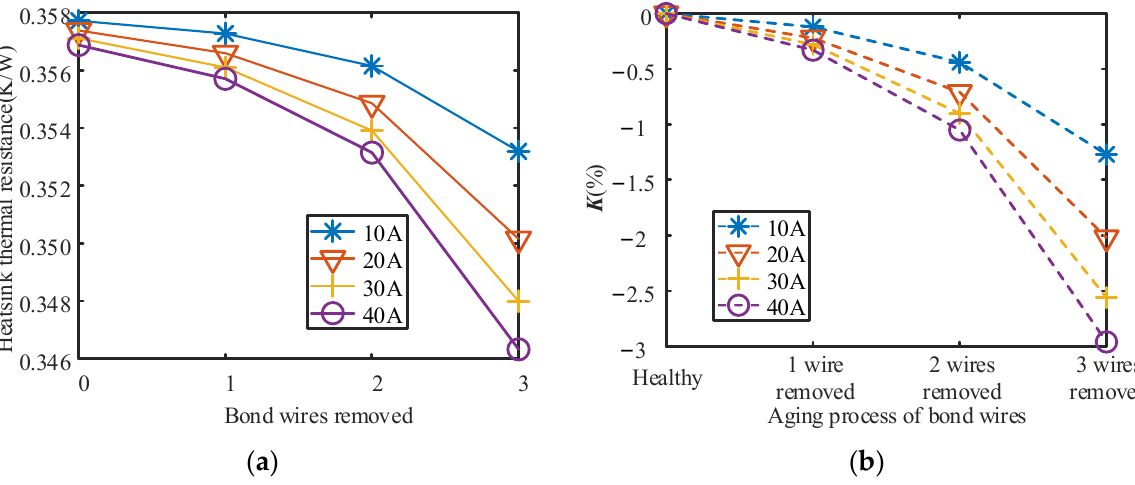
Figure 10. FEM results. ( a ) Heatsink thermal resistance Z M _ HS ; ( b ) aging ratio K.